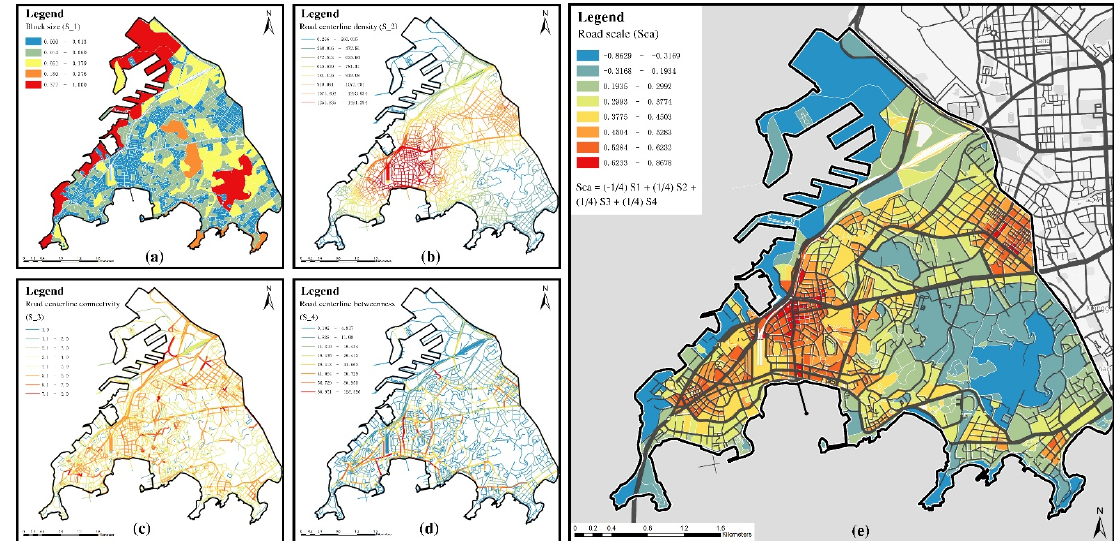
Figure 5. Road scale analysis. ( a ) Block size. ( b ) Road centerline density. ( c ) Road centerline connectivity. ( d ) Road centerline betweenness. ( e ) Road scale composite index.